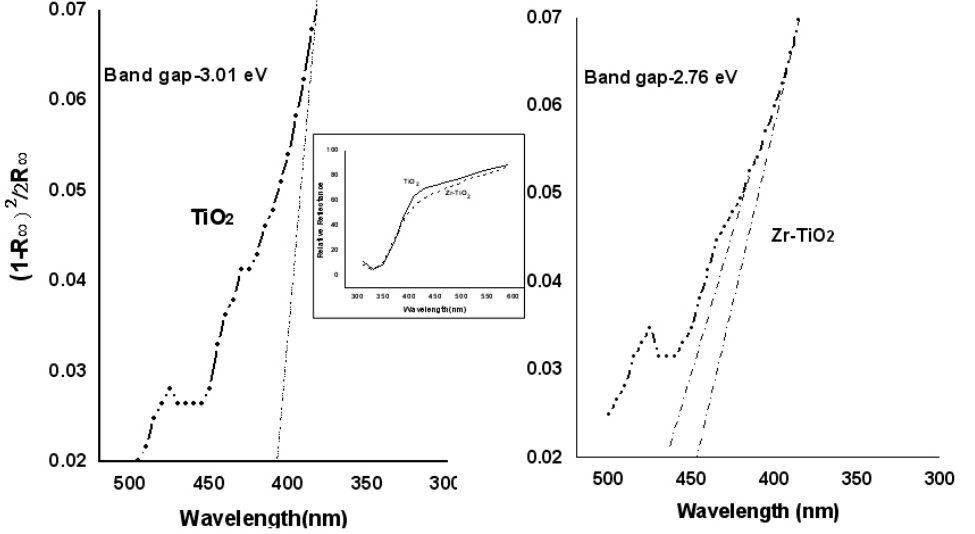
Figure 5. Kubelka-Munk plot of the photocatalysts [Inset- reflectance spectra].